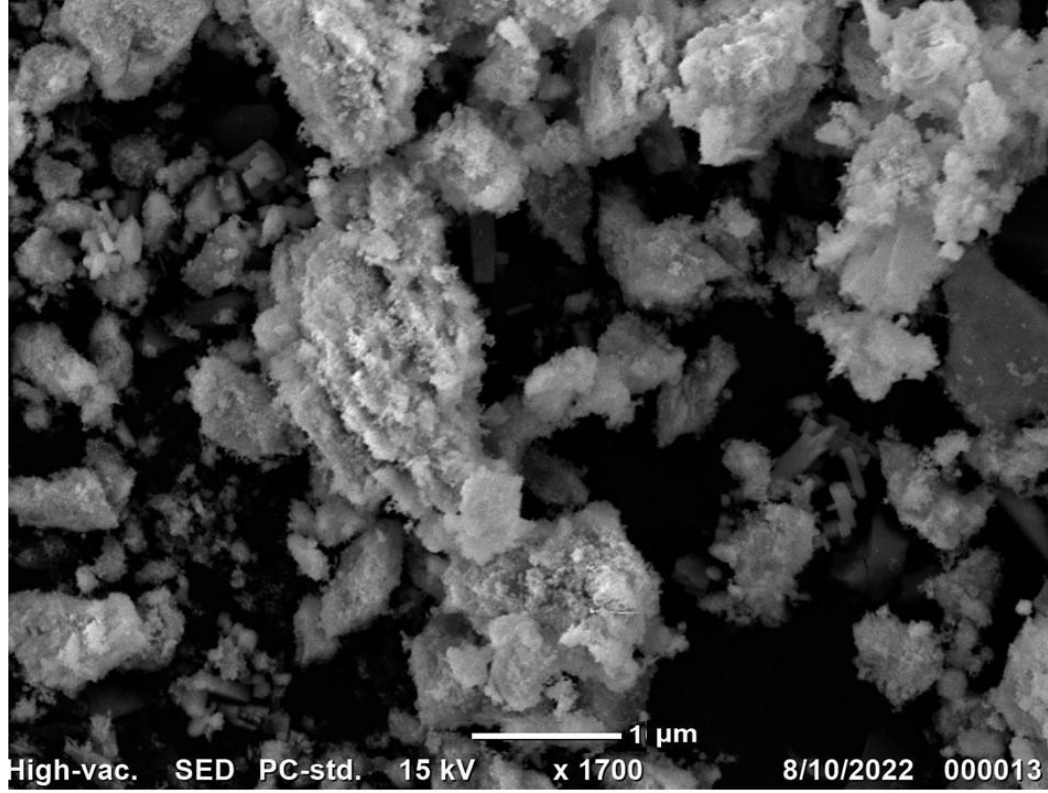
Figure 5. FESEM picture of zinc oxide NPs synthesized via the green route.